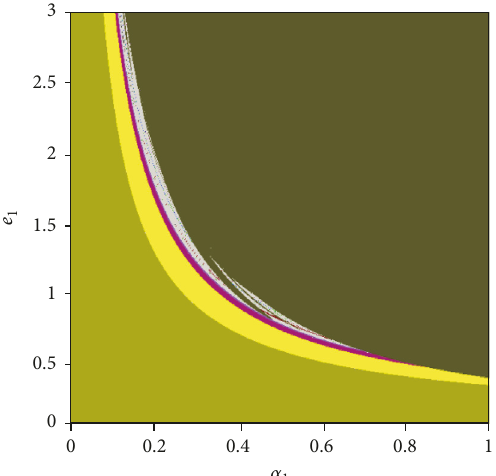
Figure 10: (𝑒 1 ,𝛼) -2D bifurcation diagram with 𝛽 = 0.2 and 𝛾 = 0.2 .